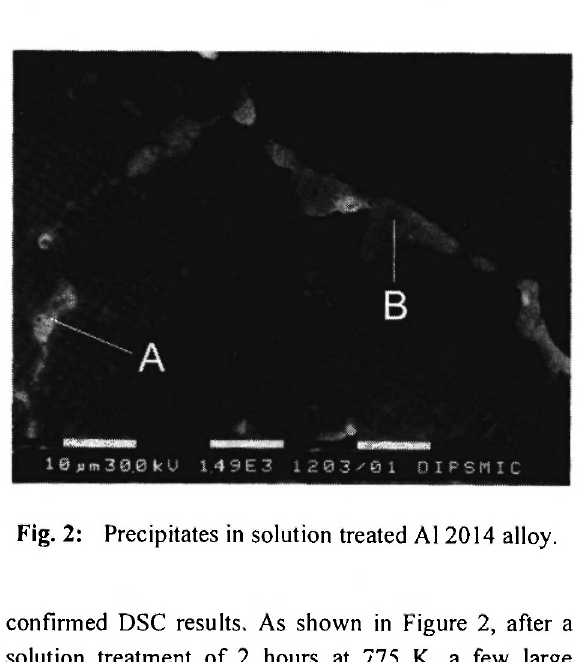
confirmed DSC results. As shown in Figure 2, after a solution treatment of 2 hours at 775 K, a few large precipitates were occasionally observed at grain boundaries in 2014 alloy. In the case of the composite, precipitates were more frequently detected; the greatest part of them placed near the reinforcement (Figure 3b).